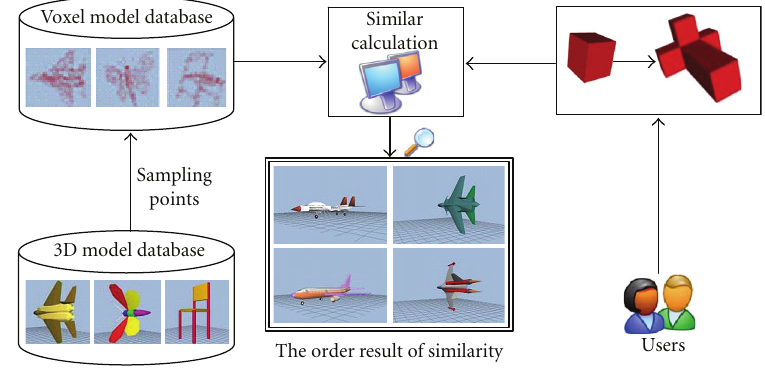
Figure 2: System flow chart.